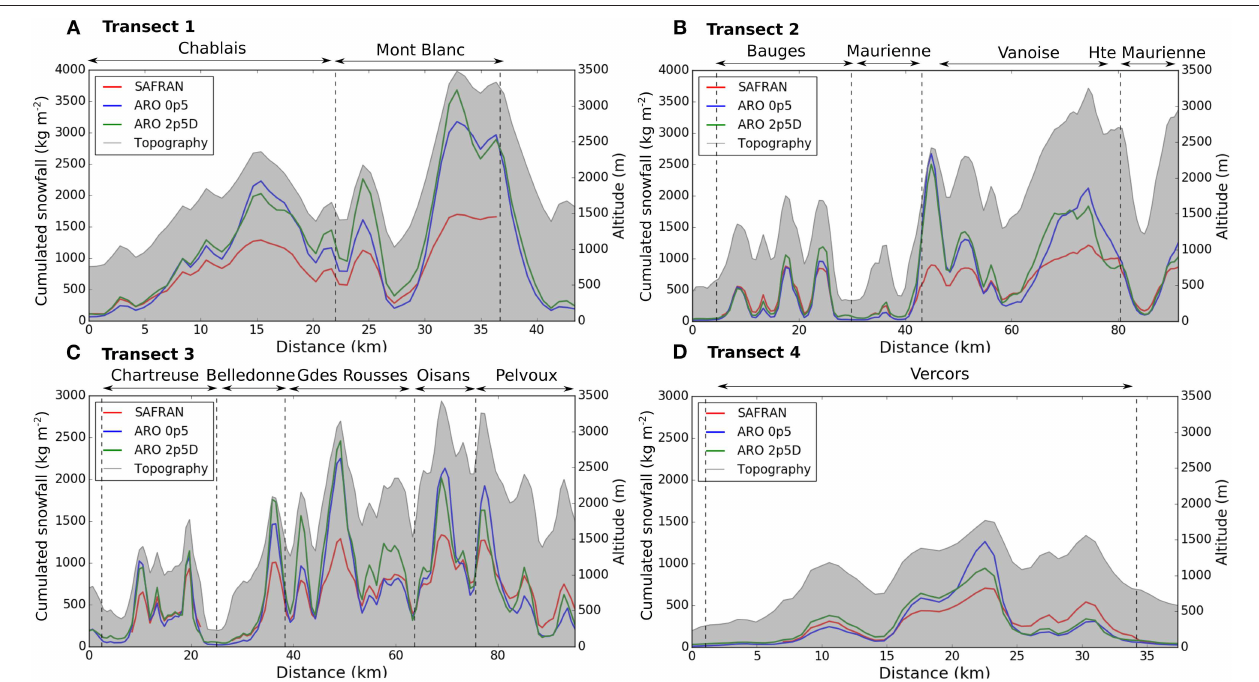
FIGURE 4 | Cross sections of total snowfall from September 1st 2011 to June 30th 2012 for AROME 500 m (blue), downscaled AROME 2.5 km (green), and SAFRAN (red) along four transects, with topography plotted on the right axis in gray. The location of the transects is given in Figure 2 . The name of the SAFRAN massifs crossed by the transect is given above each graph. Note that the transect length varies from one figure to another.